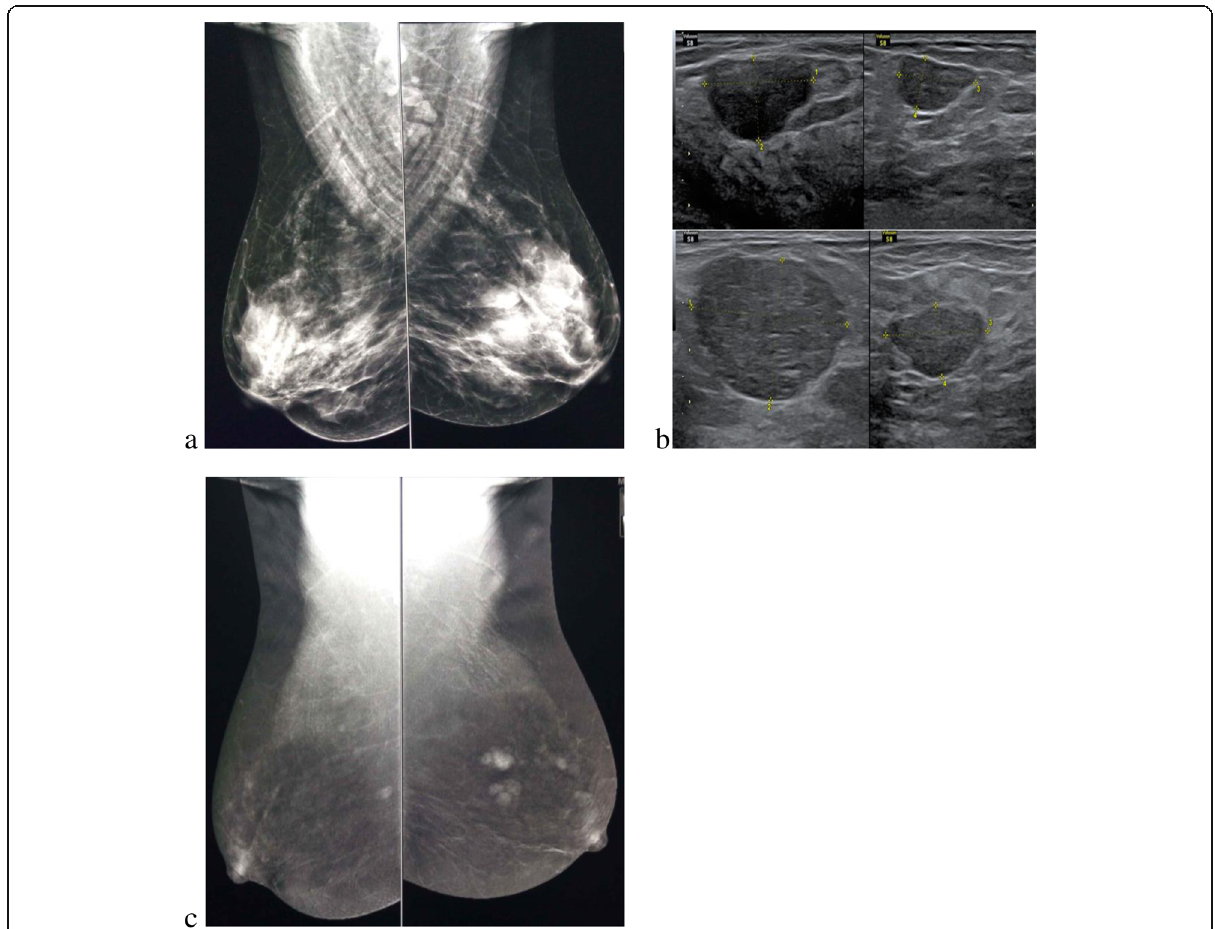
Ultrasound images of regular smoothly marginated hypoechoic fibroadenomas. c Recombined image of CEDM showing multiple mass enhancing lesions with internal non enhanced